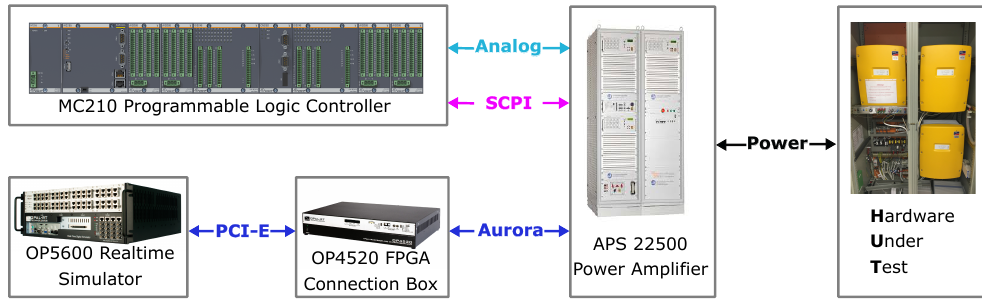
Figure 3. Possible PHiL setups in